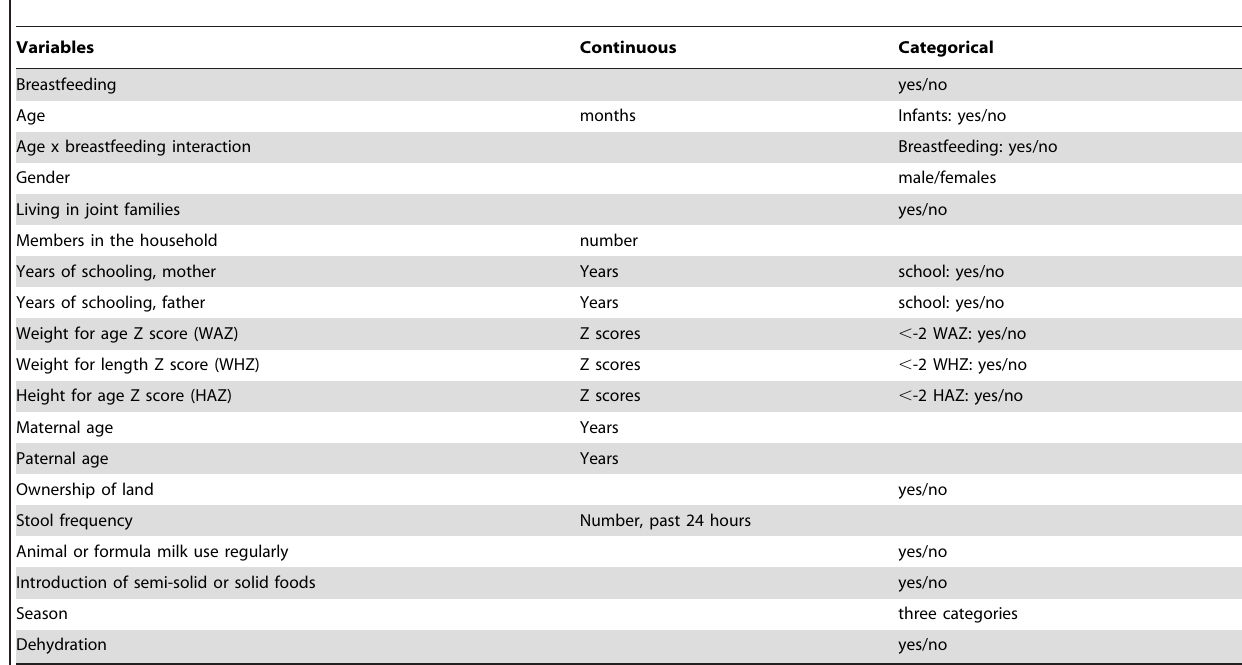
Table 1. Variables assessed in the multivariable linear regression models measuring predictors for plasma folate, cobalamin, homocysteine, or methylmalonic acid in 823 Nepalese children 6 to 35 months of